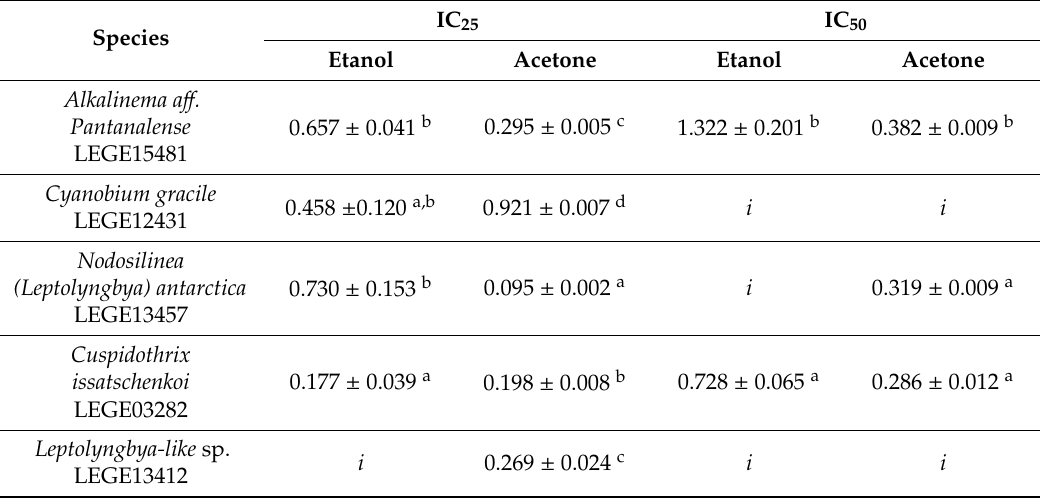
1 Di ff erent superscript letters in each column denote statistical di ff erences at p < 0.05 (ANOVA, Tukey HSD and unpaired t -test performed to compare the IC 50 values of EtOH extracts); 2 Mean ± SD of at least two independent assays; i radical scavenging did not reach IC 25 nor IC 50